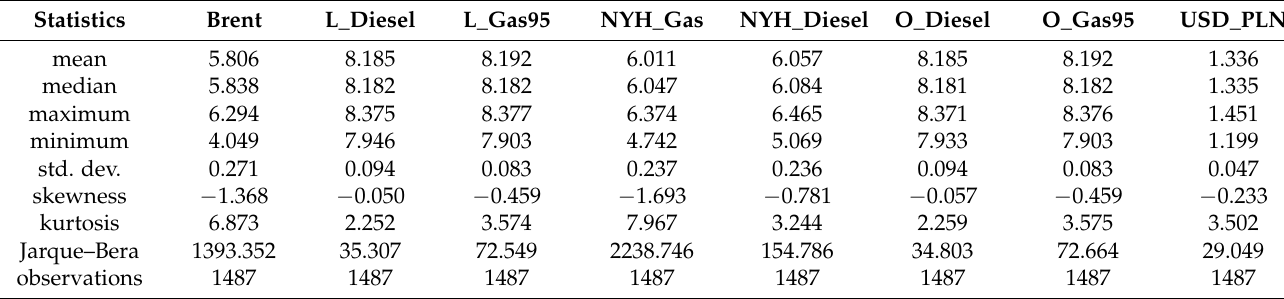
Figure 3. Time series under examination. Table 2. Descriptive